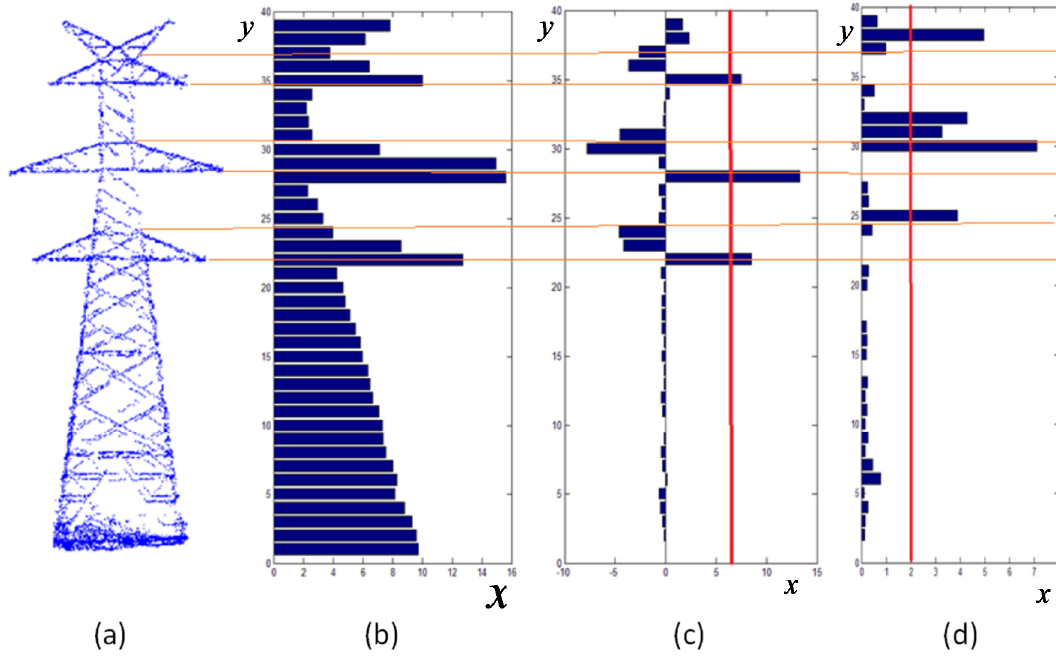
Figure 2. The initial type and parameter calculation method for a pylon. Firstly, all the points of a pylon are projected onto its main plane ( a ); A vertical profile is then sliced into several bins of a certain distance. The histogram for the length of the sliced profile is shown in ( b ); ( c ) A derivative that represents the changing length of the arms. In order to highlight the pylon’s turning points, a second derivative is calculated ( d ); and the positions where the derivatives are large are set to be 0. In all subfigures, y represents height in m. x represents length ( b ); derivative ( c ); or second derivative ( d ) in m.